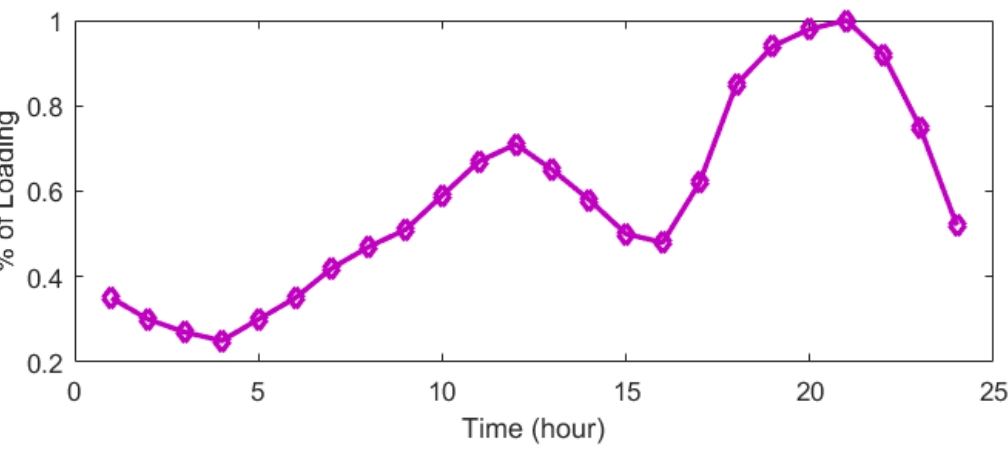
Figure 6. Percentage of network peak load during a day. Table 4. Technical information and cost of wind turbine, battery, and inverter of WT/Battery system [40].